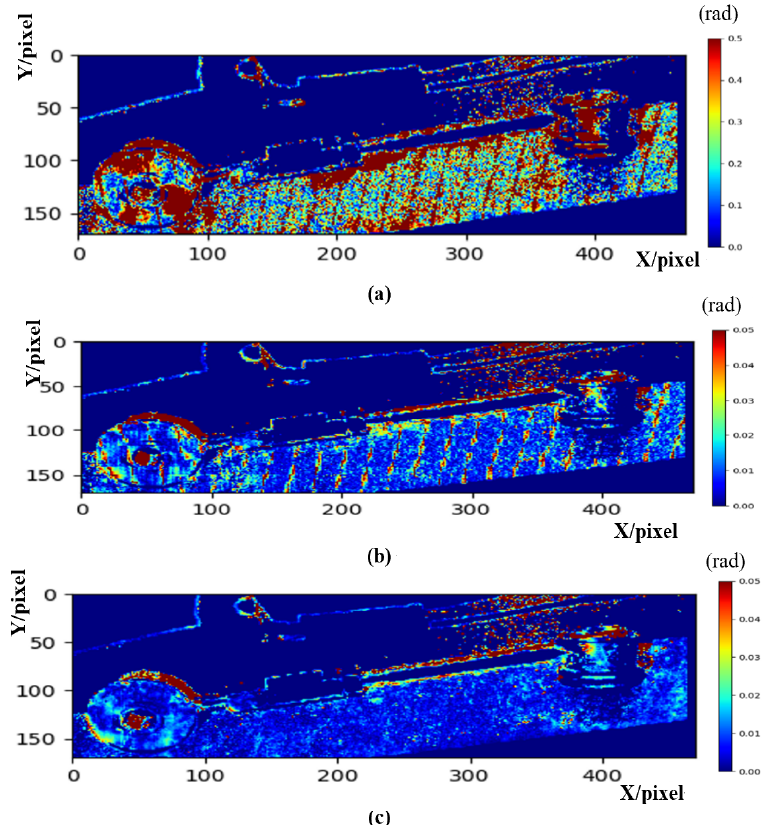
Figure 9. Error maps of predicted wrapped phase map, predicted absolute phase map, and refined absolute phase map with the corresponding MAE in the test set: ( a ) error maps of predicted wrapped phase map (MAE = 0.3204 rad); ( b ) error maps of predicted absolute phase map (MAE = 0.0200 rad); ( c ) error maps of refined absolute phase map (MAE = 0.0114 rad).